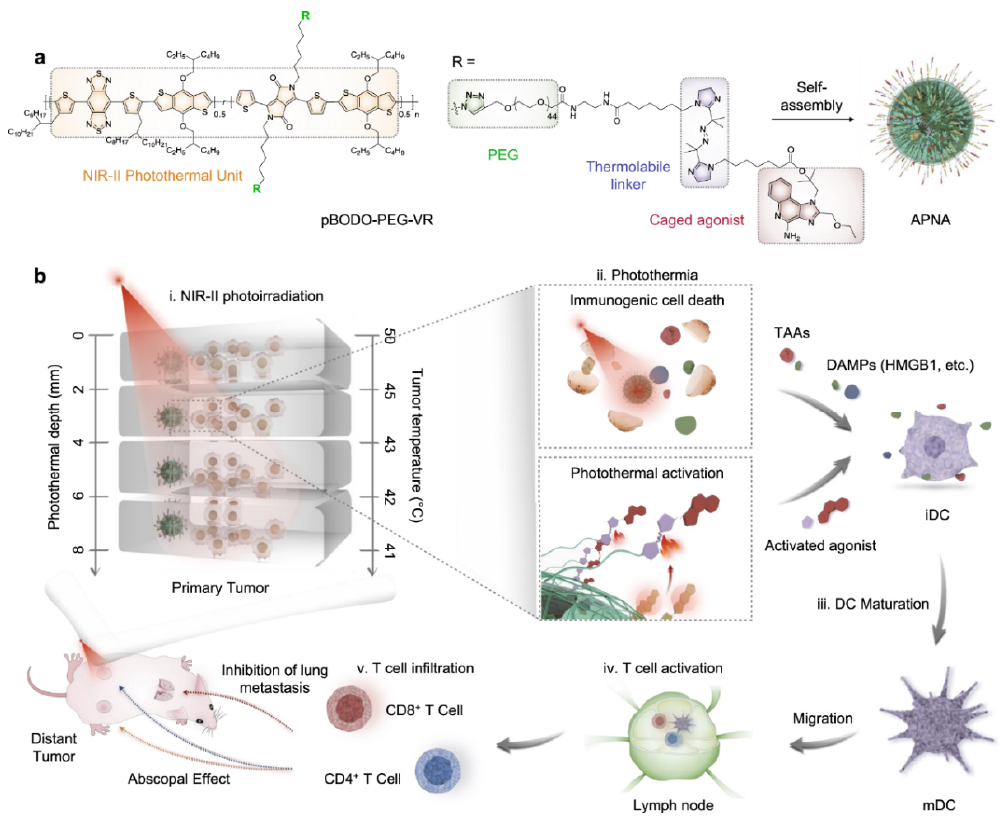
Figure 8. ( a ) Chemical structure of pBODO-PEG-VR and preparation of APNA. ( b ) Mechanism of antitumor immune response by APNA-mediated NIR-II photothermal immunotherapy. TAAs tumor-associated antigens, DAMPs damage- associated molecular patterns, iDC immatureDC, mDC mature DC, HMGB1 high-mobility group box 1 protein (Reprinted Permission from Nature, 2021 under creative common license) [76] .